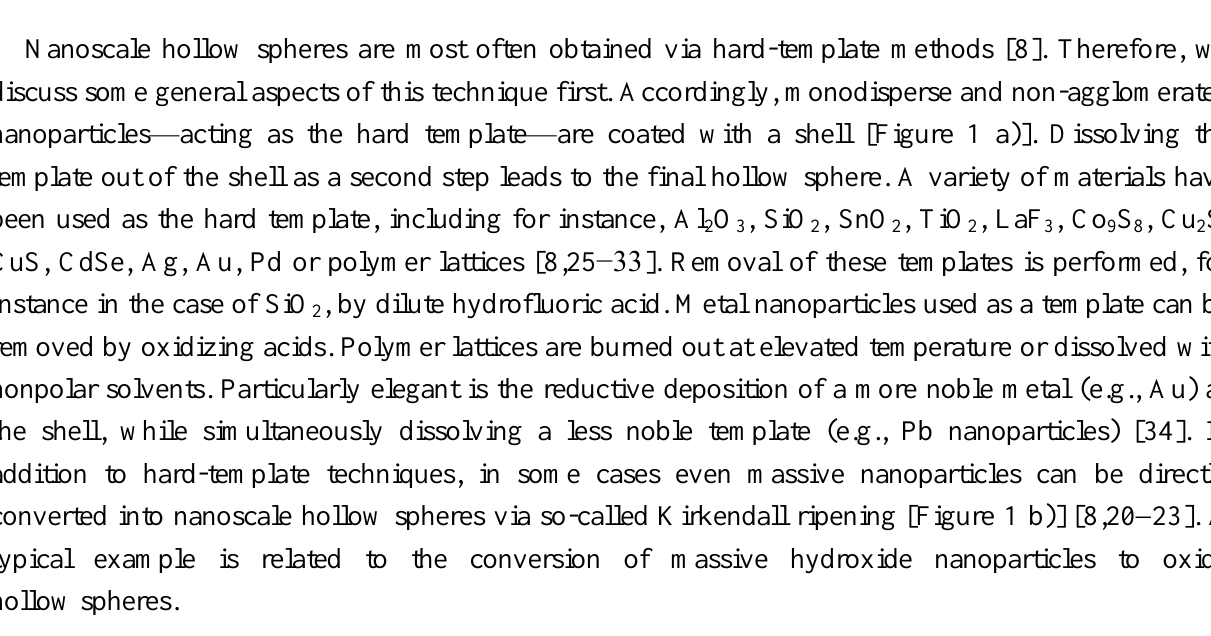
Figure 1. Scheme exploiting the synthesis of hollow spheres via: a) hard-template techniques and b) Kirkendall